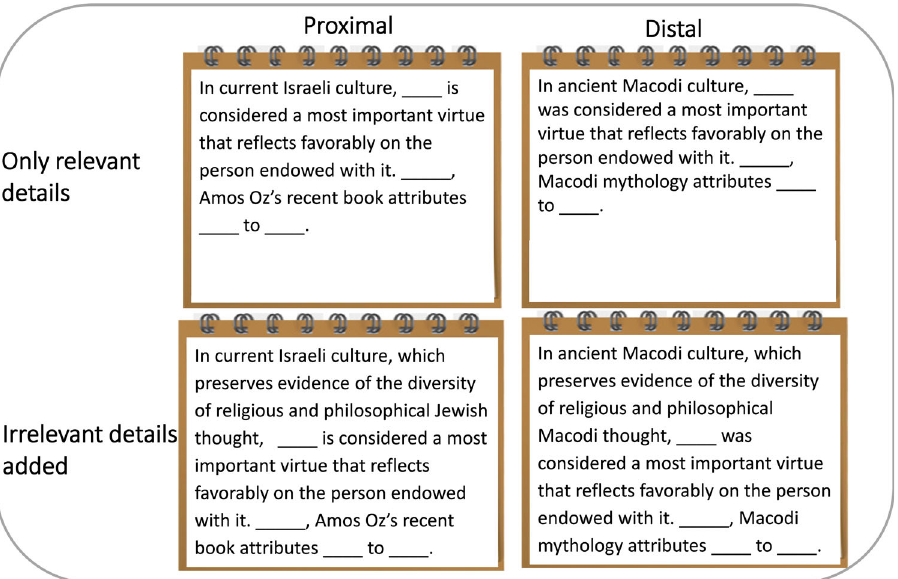
Fig. 1 Sample question in all four versions. A test question in all four versions, comprising a distance (proximal vs. distal) by relevance of details (relevant-only vs. irrelevant-added) design (Studies 2 and 3). Each participant was presented with one of the four versions of each question. Distance was manipulated between participants (i.e., a participants answered all questions in either the proximal or the distal version) whereas relevance was manipulated within participants (i.e., each participant received the relevant-only version of six questions, and the irrelevant-added version of other six questions). Each question was followed by four alternative responses, of which participants chose the best answer: (1) composure / Yet / the ability to face danger without batting an eyelid / the villain Carvilius (Molko), of all people. (2) kindness / Yet / the willingness to help the needy at any time / the hero Carvilius (Molko), of all people. (3) modesty / Indeed / unparalleled arrogance / the revered hero Carvilius (Molko). (4) physical strength / Indeed / great physical power / the notorious villain Carvilius